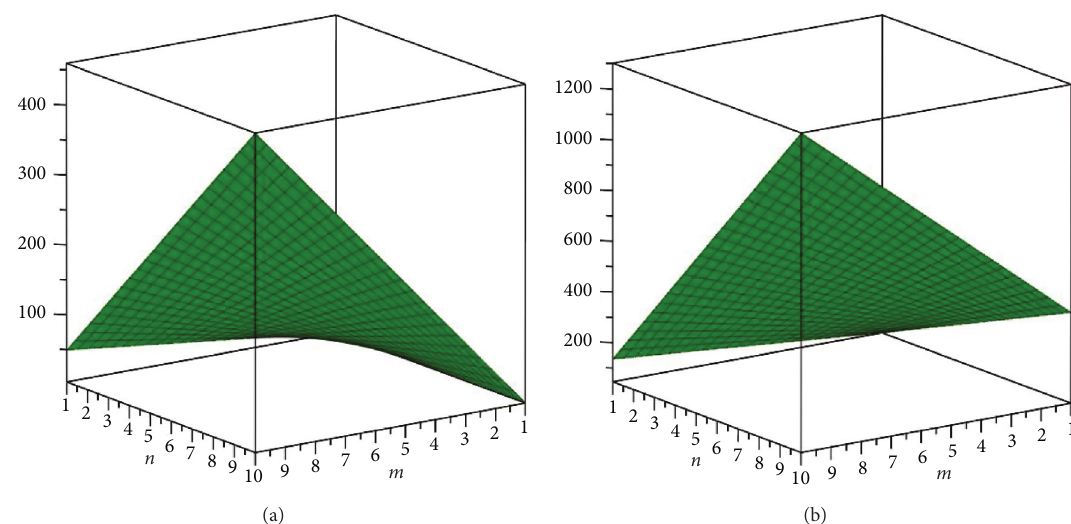
Figure 6: (a) The atom-bond connectivity index. (b) The geometric-arithmetic